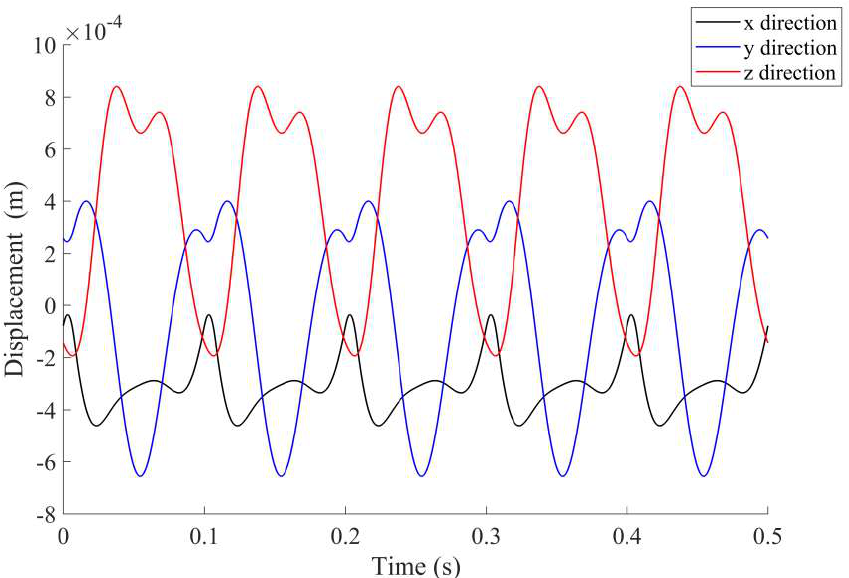
Figure 12. Time responses of tool displacement at P 1 under a percussive force along—X direction.